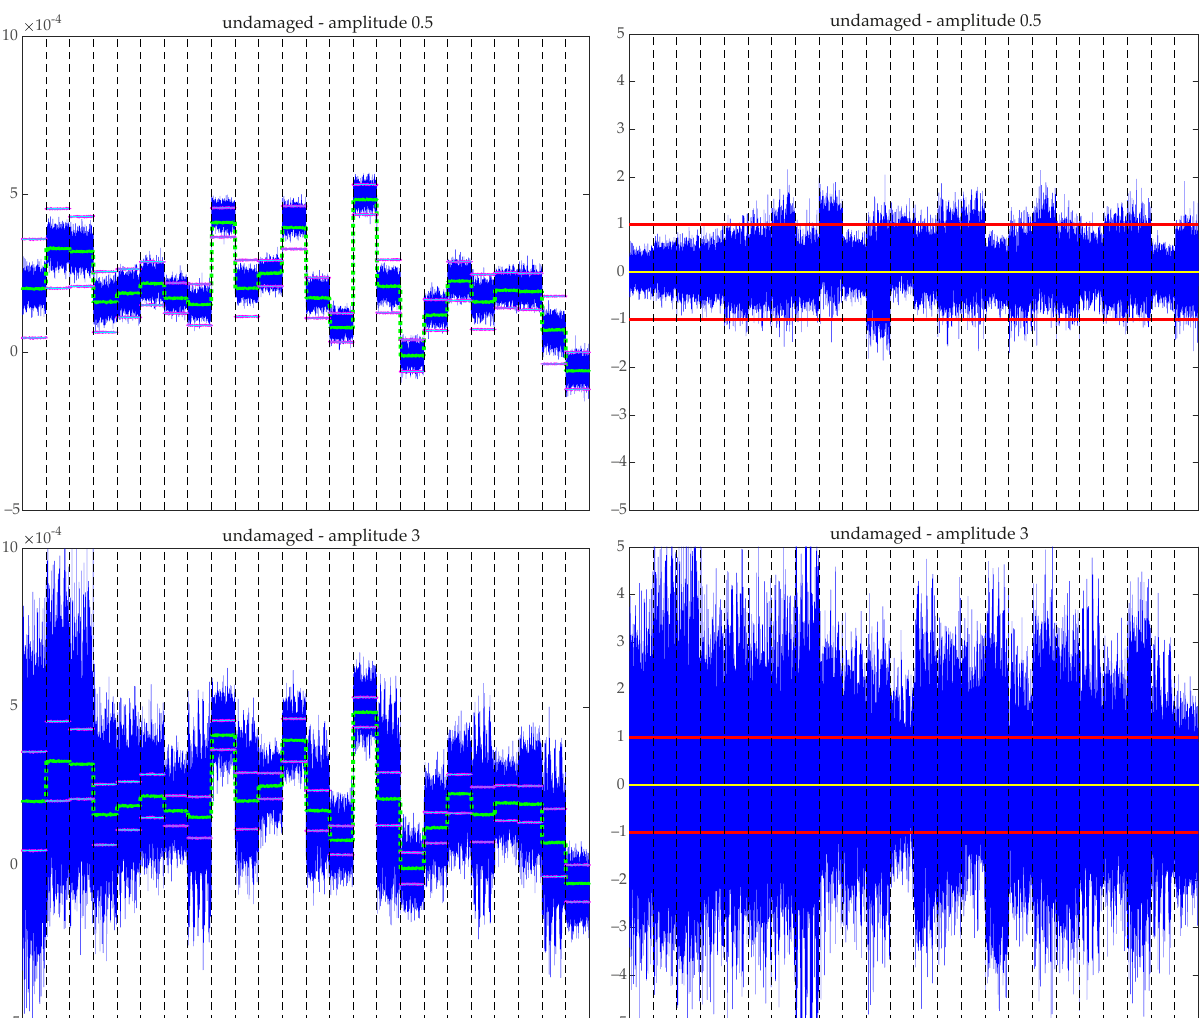
Figure 8. Raw signal (left) versus MCUGS signal (right) for two undamaged samples (amplitudes 0.5 (top) and 3 (bottom). Raw signals (blue) are shown along with the mean values µ k (green) and the representation of the standard deviations j ± σ k ± σ k µ k (cyan) and µ k (magenta). The normalized data have zero mean (yellow) and unitary deviation (red). j j MCUGS MCGS Dashed vertical lines separate the measures of the 24